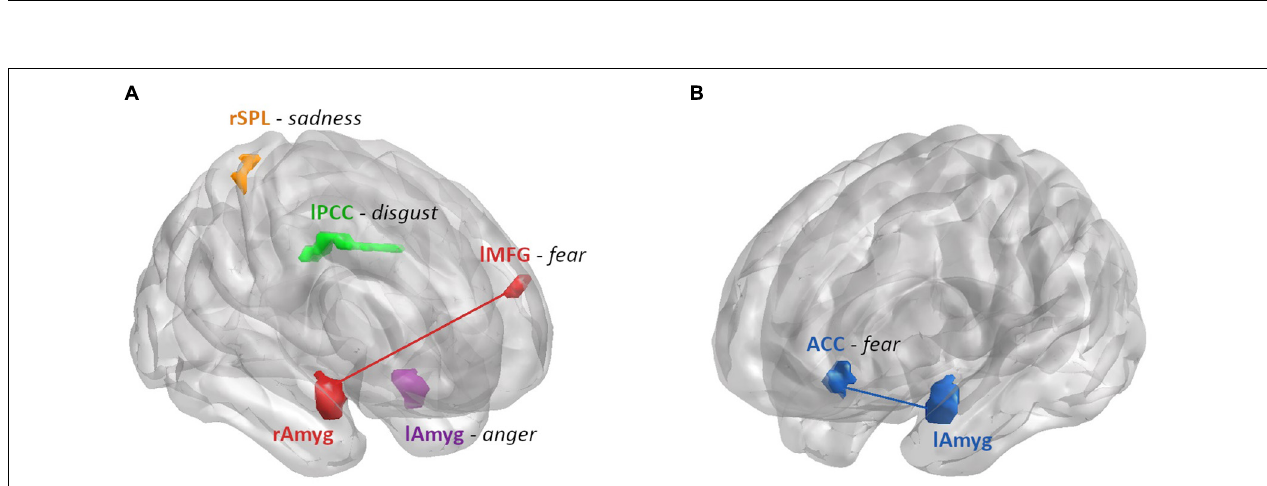
FIGURE 7 | Summary of the brain areas that showed a differential relationship between ALFF or connectivity strength and emotion recognition performance by hormonal status in women (A) and sex (B) . (A) Areas modulated by hormonal status: ALFF and RT for anger were found to be moderately positively correlated for women on A-OC in the left amygdala (purple). ALFF and accuracy for disgust were found to be moderately negatively correlated for women on AA-OC in the left PCC (green). ALFF and accuracy for sadness were found to be positively correlated for naturally cycling women, whereas they were negatively correlated for women on AA-OC in the right SPL (orange). Connectivity strength between right amygdala-left MFG (red) and accuracy for fear were found to be negatively correlated for naturally cycling women, whereas they were positively correlated for women on AA-OC. (B) Areas modulated by sex: Connectivity strength between the left amygdala-ACC (blue) and RT for fear were found to be positively correlated for men, whereas they were negatively correlated for naturally cycling women.